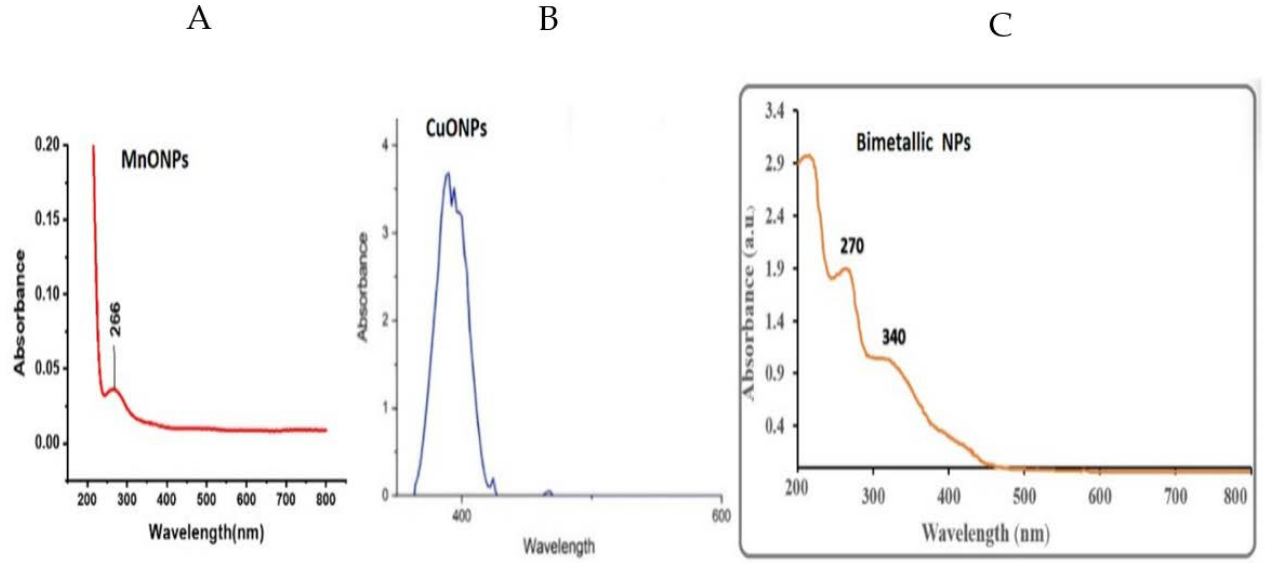
Figure 1. UV-vis spectra of MnONPs ( A ), CuONPs ( B ), and Cu-Mn bimetallic nanoparticles ( C ) biosynthesized from pumpkin seed extract.